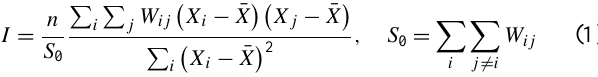
Fig. 3. Weather series for the irrigation experiment (in 2010), mean T air is the daily mean temperature ( ◦ C ), I is the infiltration from irrigation ( mmd − 1 ).